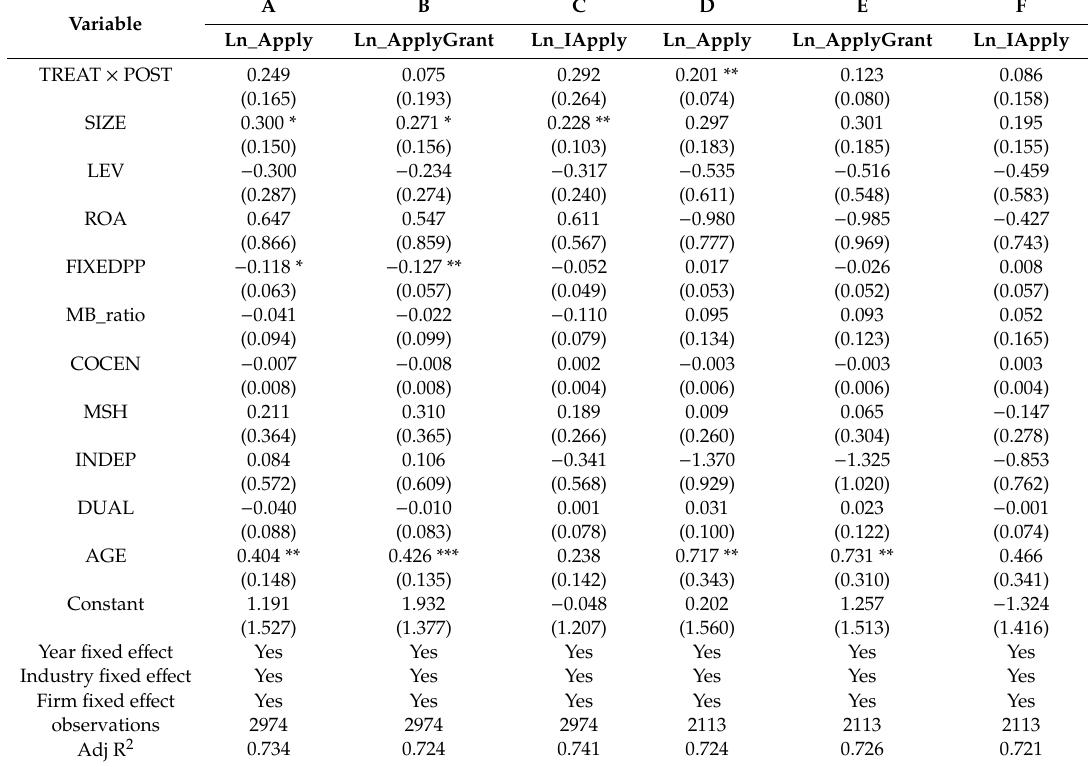
Table A2. Impact of China’s carbon emissions and trading pilot (CCETP) on innovation